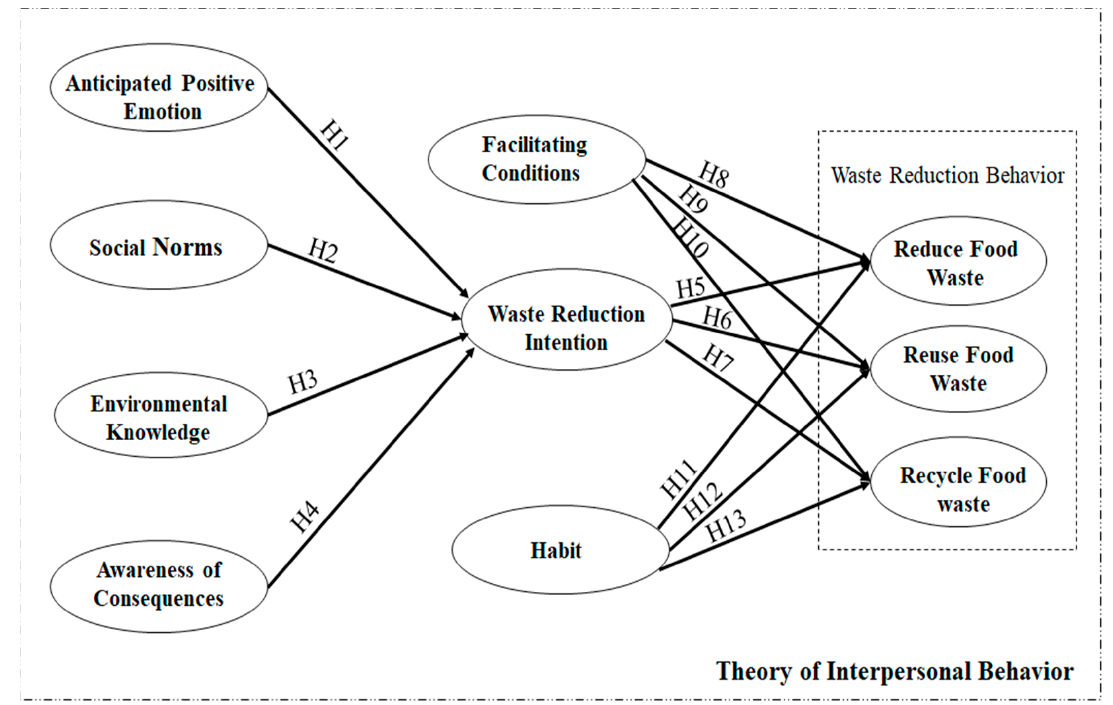
Figure 1. Conceptual Framework.